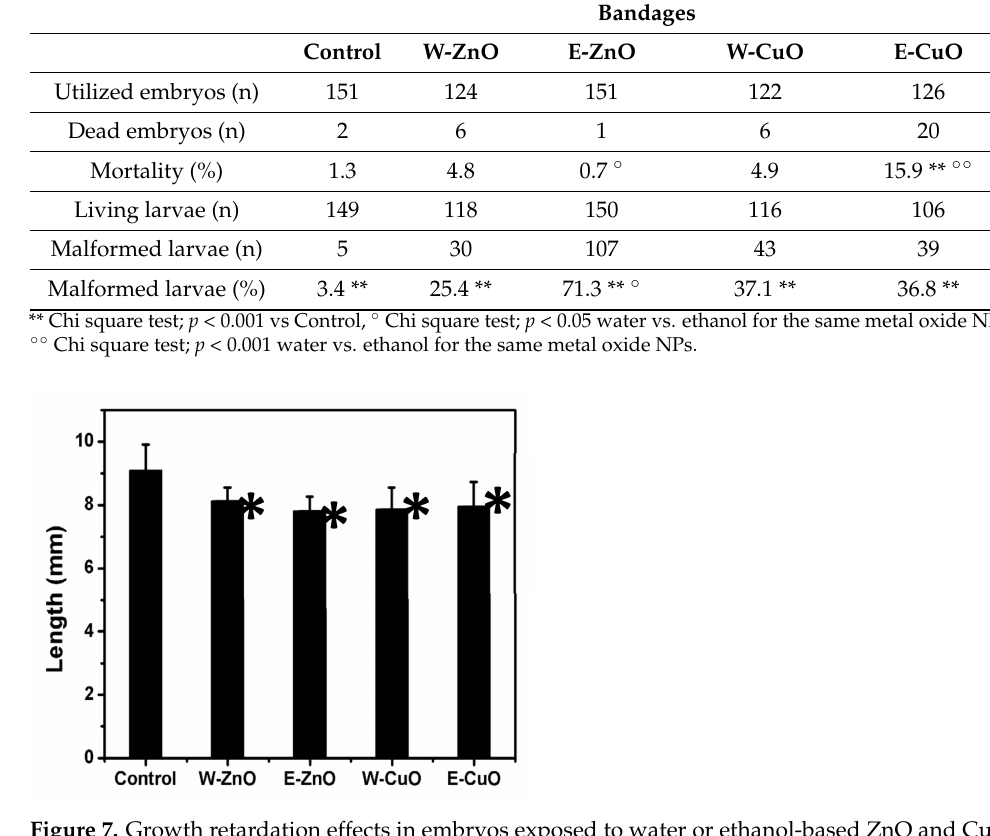
Figure 7. Growth retardation effects in embryos exposed to water or ethanol-based ZnO and CuO NP-coated bandages. * Statistically different from the control (ANOVA, p <